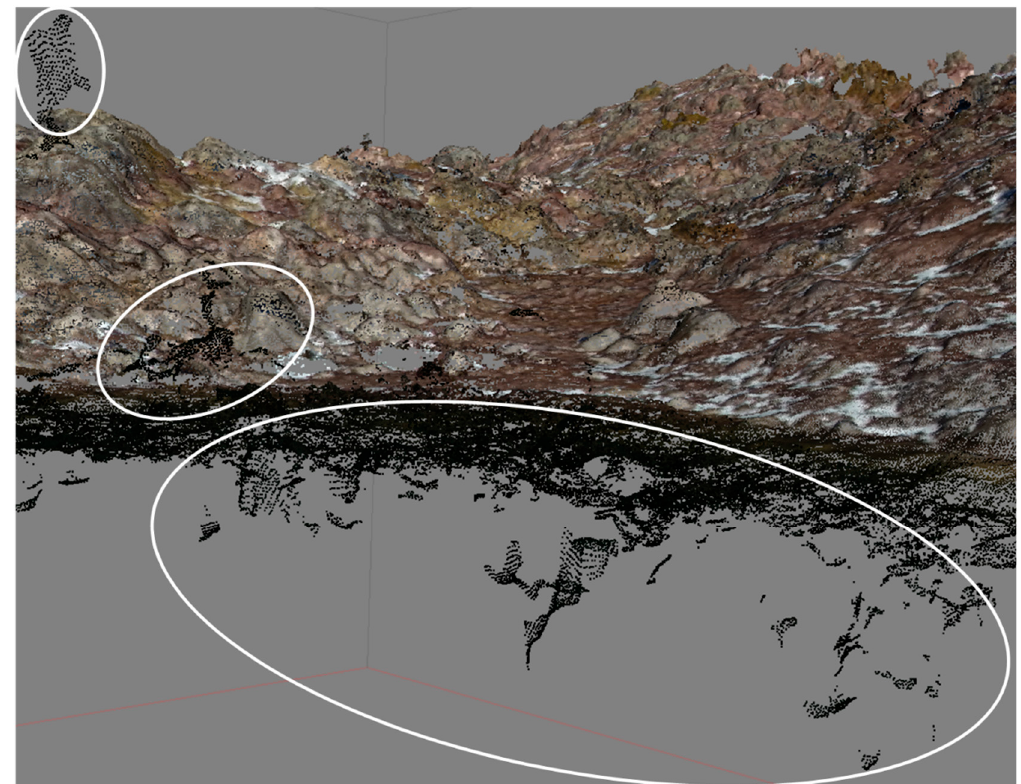
Figure 8. Distortion in the Newcastle Dam point cloud produced when water is not omitted in the sparse cloud alignment. Erroneous points created due to the water are shown in white circles.